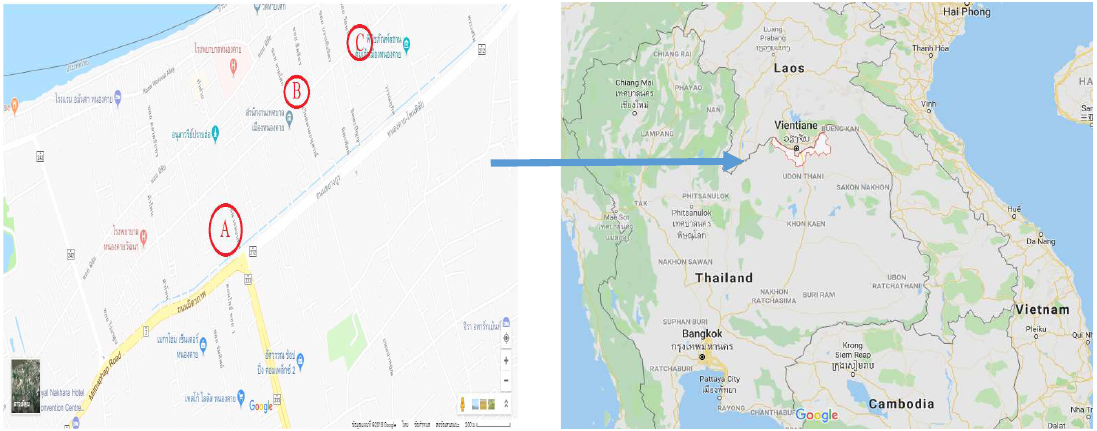
Fig. 1. Map of street food restaurants in Nong Khai Municipality )Google Maps,